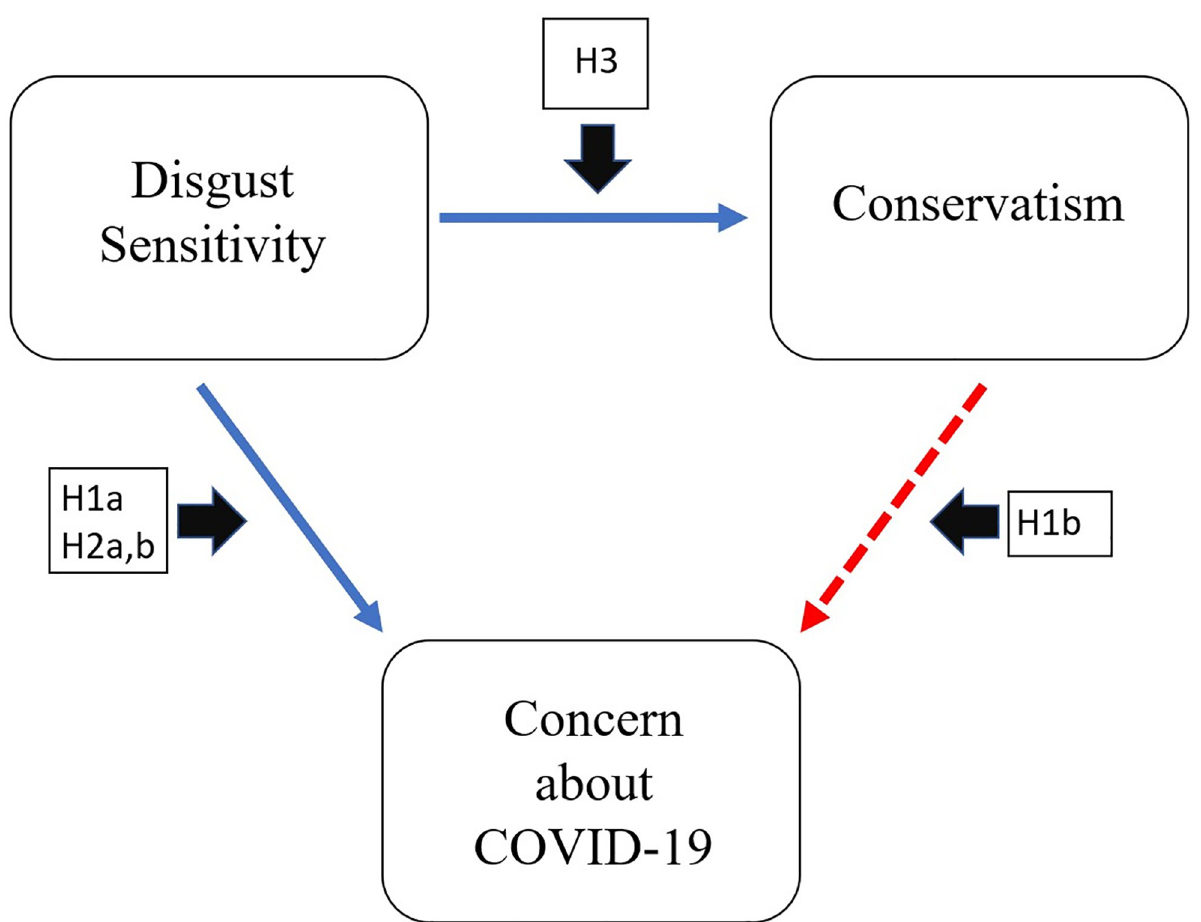
Fig 1. Model of the theorized interrelations among our three target variables, with hypotheses positioned according to the specific associations that they examine. Solid blue arrows indicate positive associations and dashed red arrows indicate negative associations.